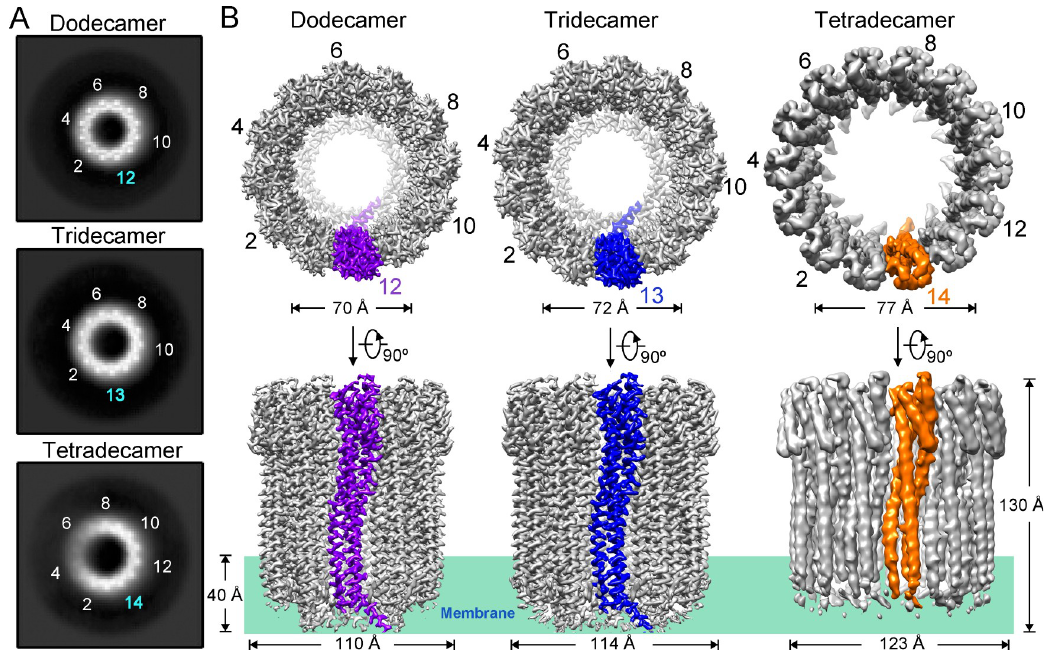
Fig 1. Cryo-EM structures of the ClyA pore complexes. ( A ) Top view (or bottom view) of the dodecamer, the tridecamer and the tetradecamer from 2D class averages of the ClyA pore complexes. The numbers of symmetric features are indicated. ( B ) The final three-dimensional reconstruction electron microscopy density maps of the dodecamer, the tridecamer, and the tetradecamer at the resolution of 2.8 Å , 3.2 Å and 4.3 Å . Top views and side views are shown. One protomer from each oligomer is shown in purple, blue or orange for